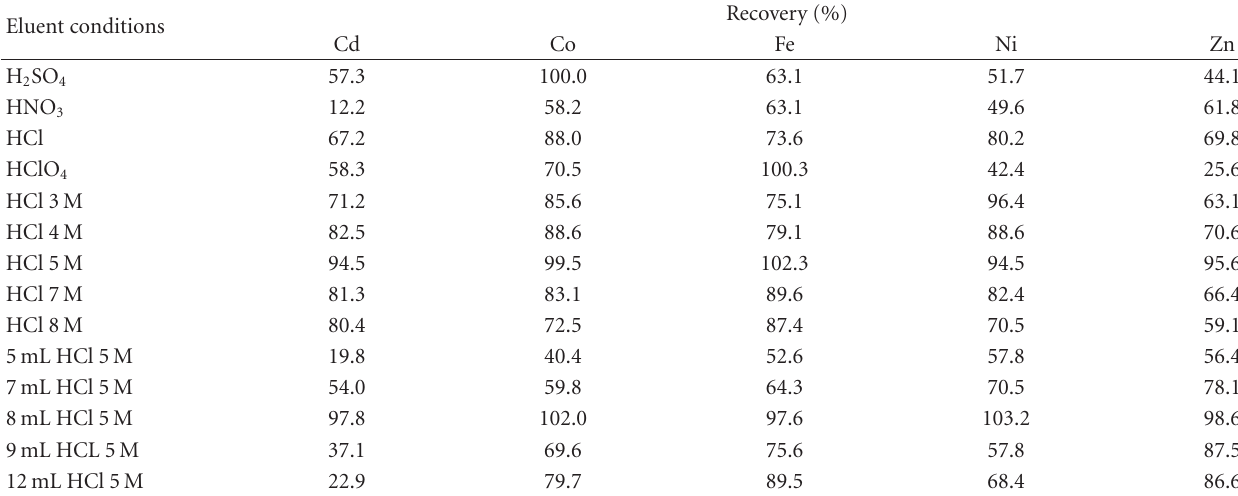
Table 2: E ff ect of type and concentration of eluting agent on recovery of analytes ( N = 3). Eluent